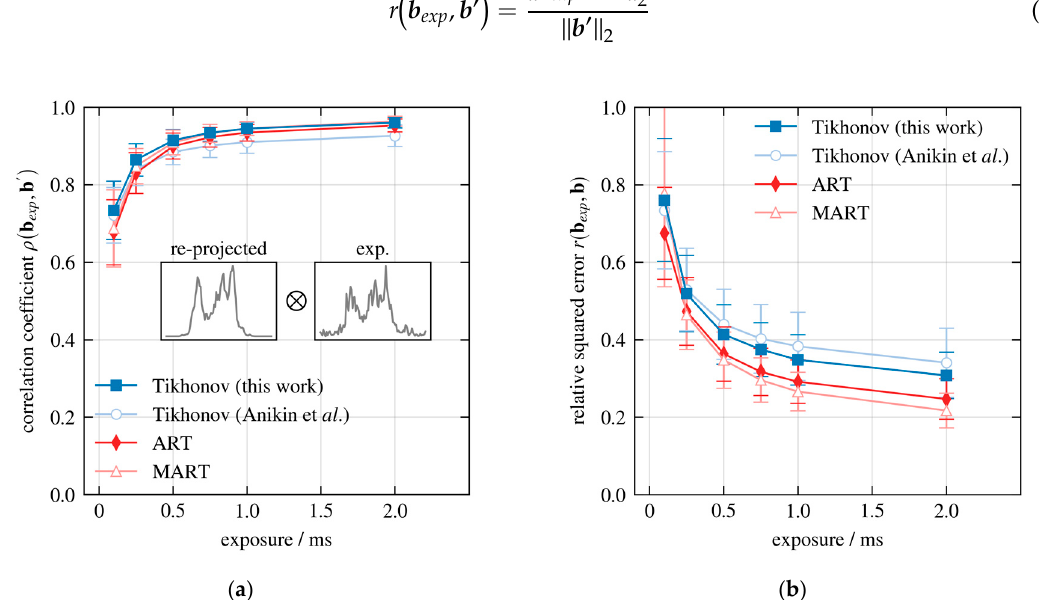
Figure 8. Comparison of a simulated (reprojected) and experimental projection direction, if the latter is omitted in the reconstruction process: ( a ) Normalized cross-correlation coefficients and ( b ) relative squared error between reprojected and experimental projection data for different reconstruction algorithms.